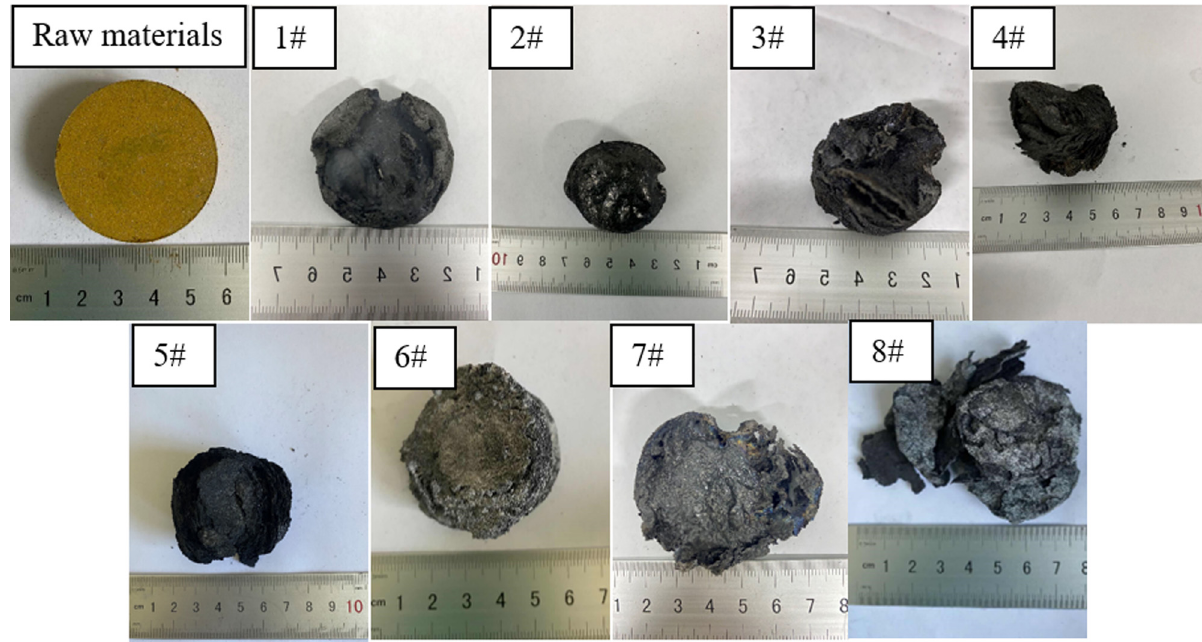
Figure 4: The macro morphology of the samples before and after the reaction.